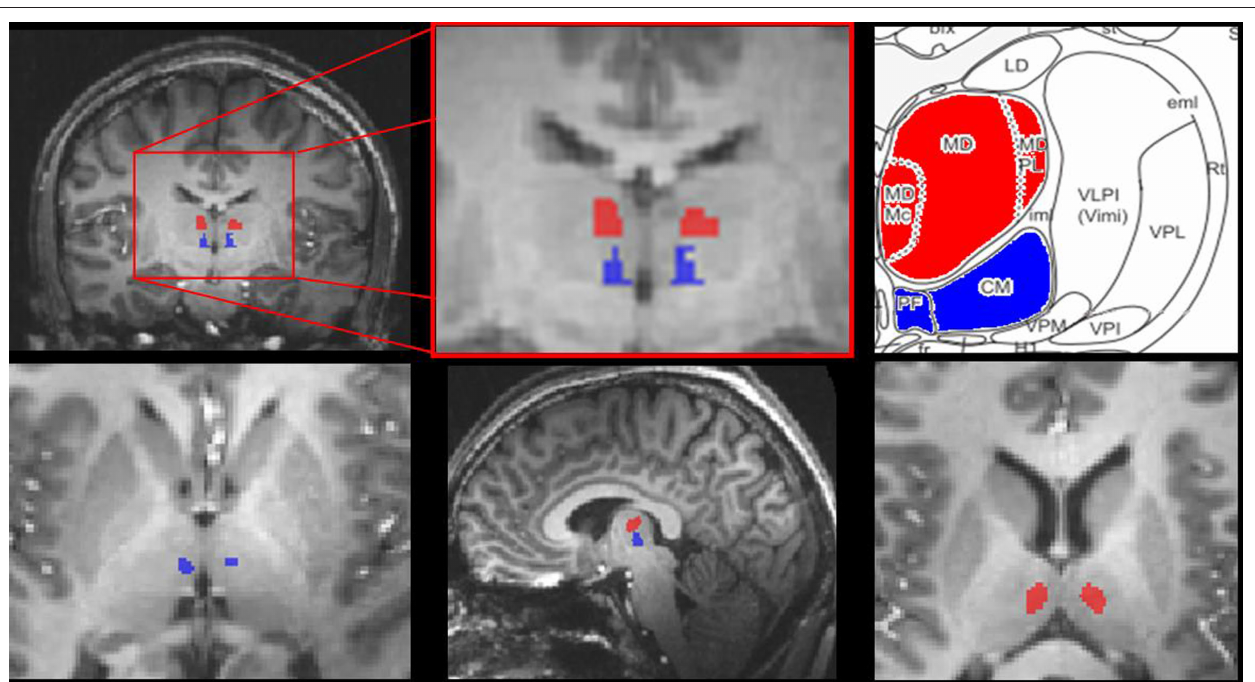
anticipation], activated the intralaminar centromedian/parafascicular thalamic nucleus (blue voxels) (conj. p < 0.05, x : − 5, y : − 13, z : 10, right; z: 3, left). Right upper figure adapted from Mai, J., Assheuer, J., and Paxinos, G. (2004). Atlas of the Human Brain. San Diego: Academic Press/Elsevier.